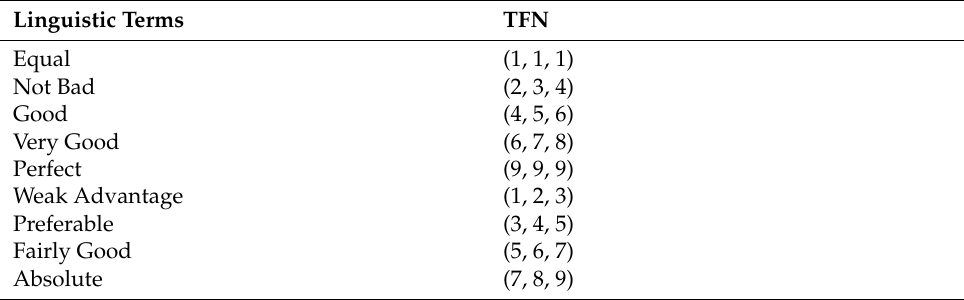
Table 1. Fuzzy comparison measures or